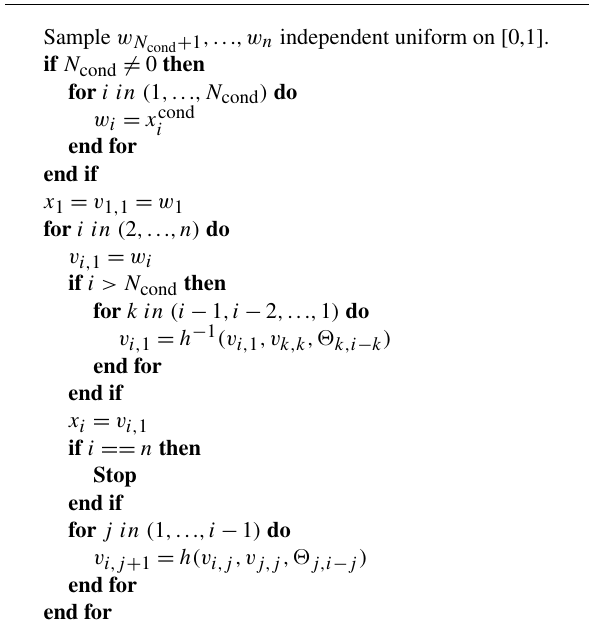
Figure B1. (a) Representation of the five-dimensional D-vine in Eq. (6). There are 4 trees ( T 1 ,T 2 ,T 3 ,T 4 ) and 10 edges. Each edge represents a pair-copula density, and the label indicates the subscript of the corresponding copula. For example, the edge 43 | 5 represents the copula density c 43 | 5 . The decomposition of the joint pdf related to the represented vine is obtained by multiplying all the represented pair-copula densities (10 in this case) and the marginal pdfs of each variable. For more details, see Aas et al. (2009). (b) Representation of the three-dimensional vine in Eq. (B3). There are two trees ( T 1 and T 2 ) and three edges.